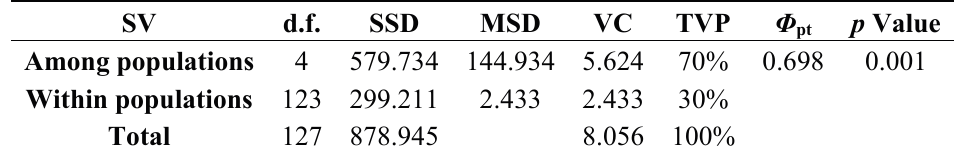
Table 2. Analysis of molecular variance (AMOVA) for the C. japonicum